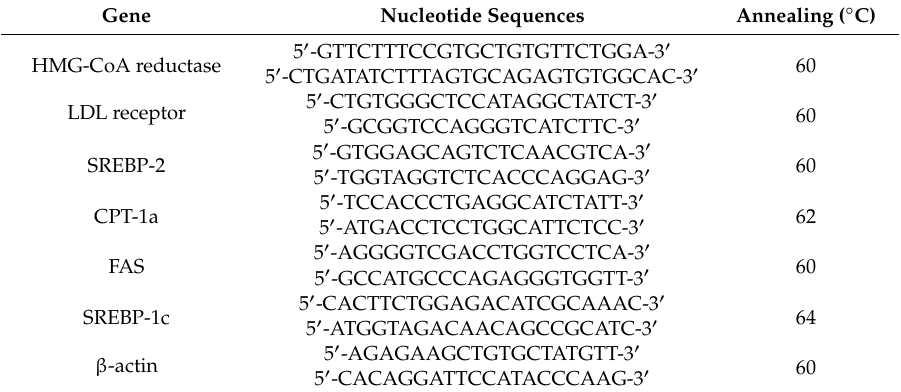
Table 2. PCR primers and conditions used for real-time PCR in the